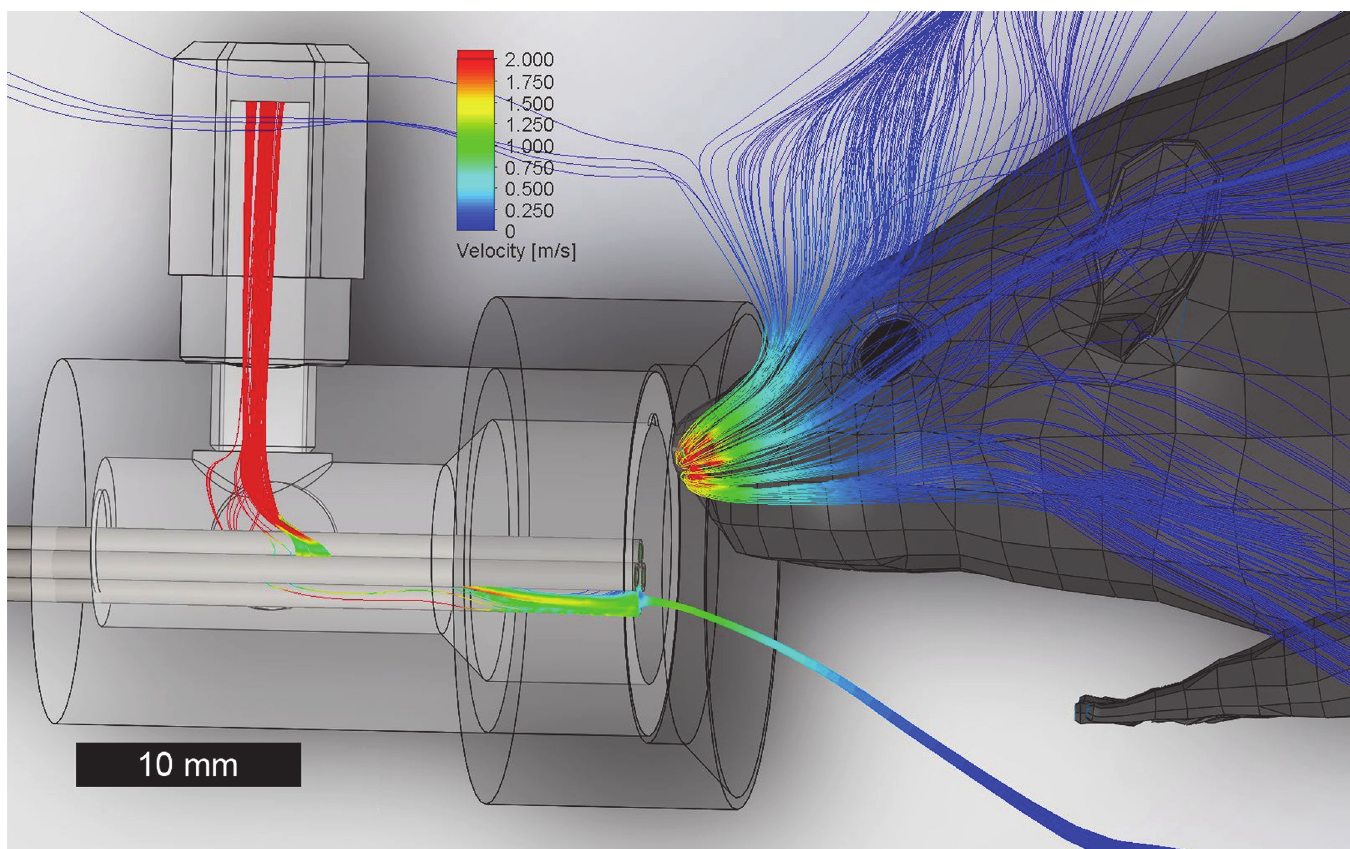
Fig 1. Flow modeling of the setup. A flow study was performed for particles at the tip of one of the lick spout tubes (in the center of the surrounding vacuum tube) and particles at the nares of a mouse model. The vacuum (upper left, red) generates an airflow preventing trajectories between the nares (inhaling, conservatively at the maximum rate reported for rats, red) and the lick